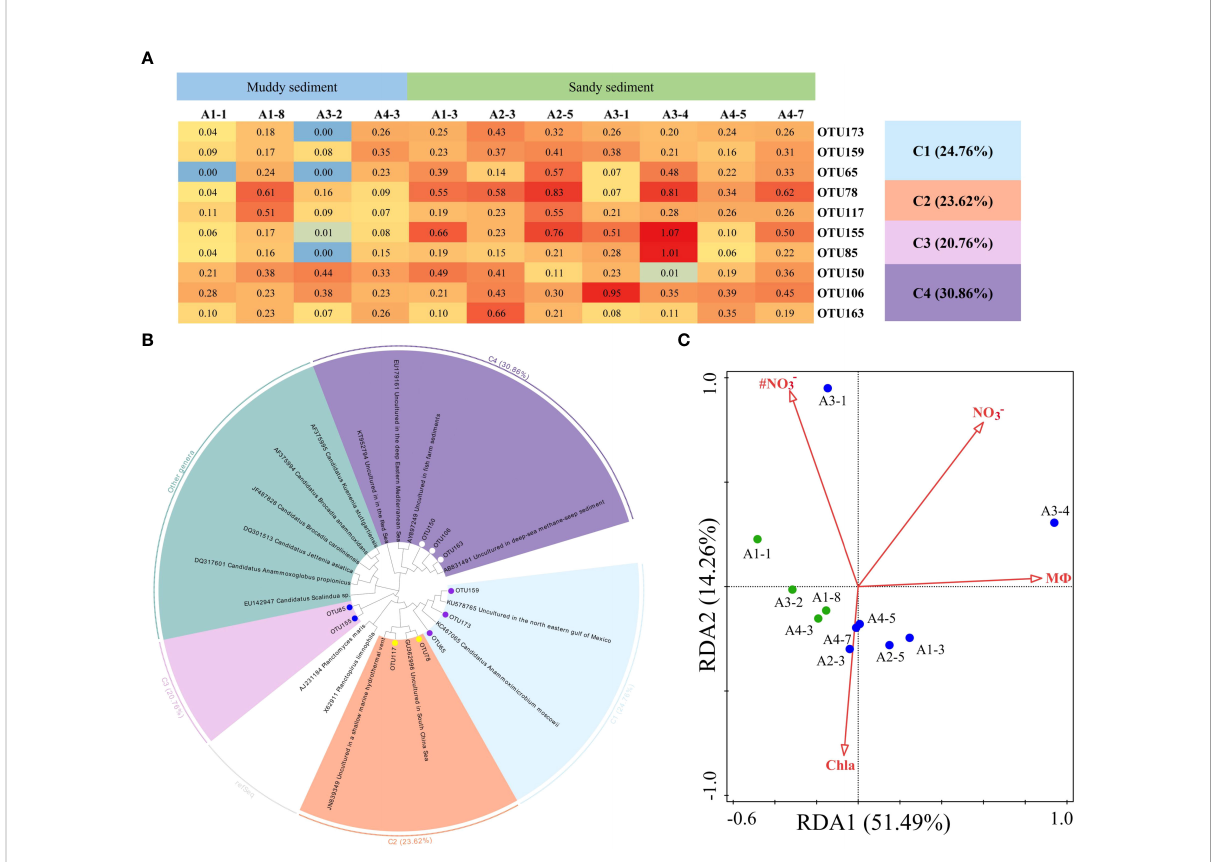
FIGURE 8 (A) The heat map of the dominant anammox OTUs for the 16S rRNA gene (top 10 OTUs, 97% cutoff). (B) Reconstructed phylogenetic tree with neighbor-joining method of 16S rRNA gene sequences (bootstrap 1000). (C) The redundancy analysis for environmental factors and the AMX 16S gene-encoded anammox bacterial